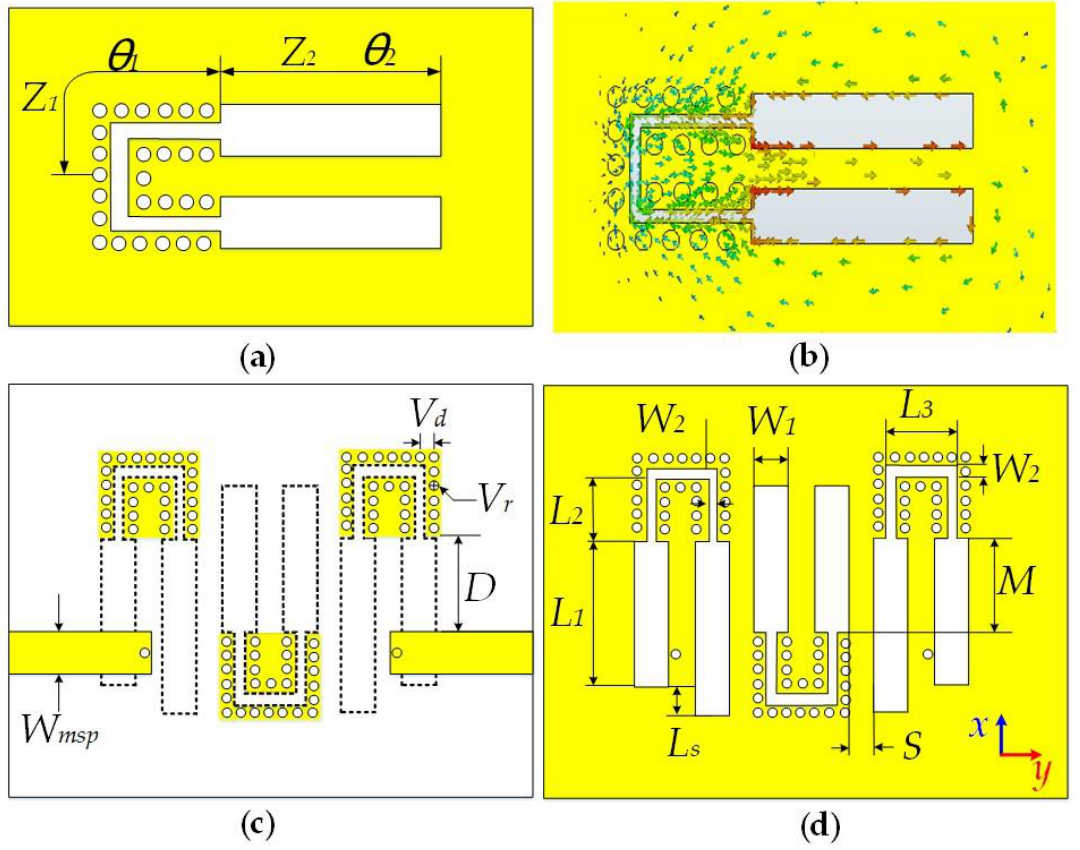
Figure 1. The proposed BPF. ( a ) The SIR composed of PWS, ( b ) the current distribution at the resonance frequency, ( c ) the top view, ( d ) the bottom view.